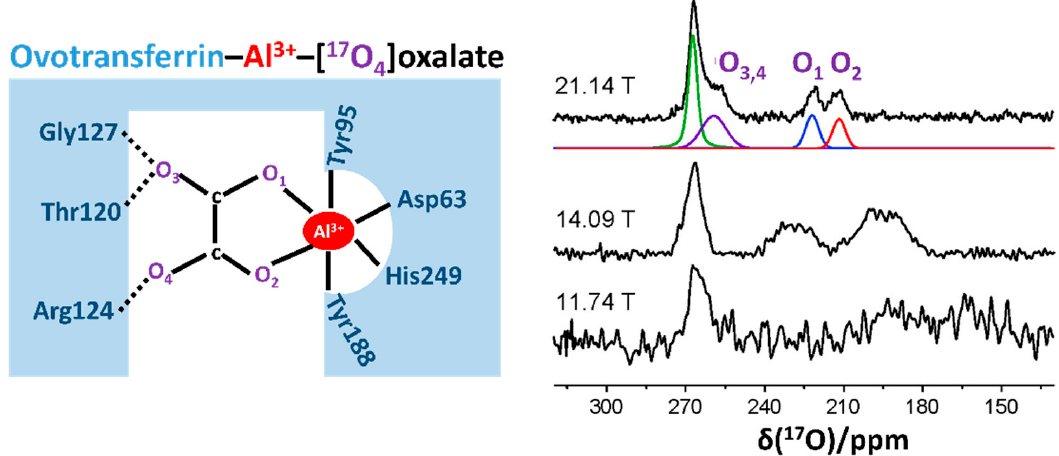
Figure 2. Schematic representation of the oxalate binding site in the ovotransferrin (OTf)–Al 3+ complex (left panel), and the solution-state 17 O quadruple central transition NMR spectra of [ 17 O 4 ]oxalate bound to OTf-Al 3+ at different magnetic fields of 21.14 T, 14.09 T, and 11.74 T, respectively (right panel). The deconvoluted 17 O signals for the spectrum at 21.14 T are also represented in distinctive colors. The figure was reproduced with permission from [18].